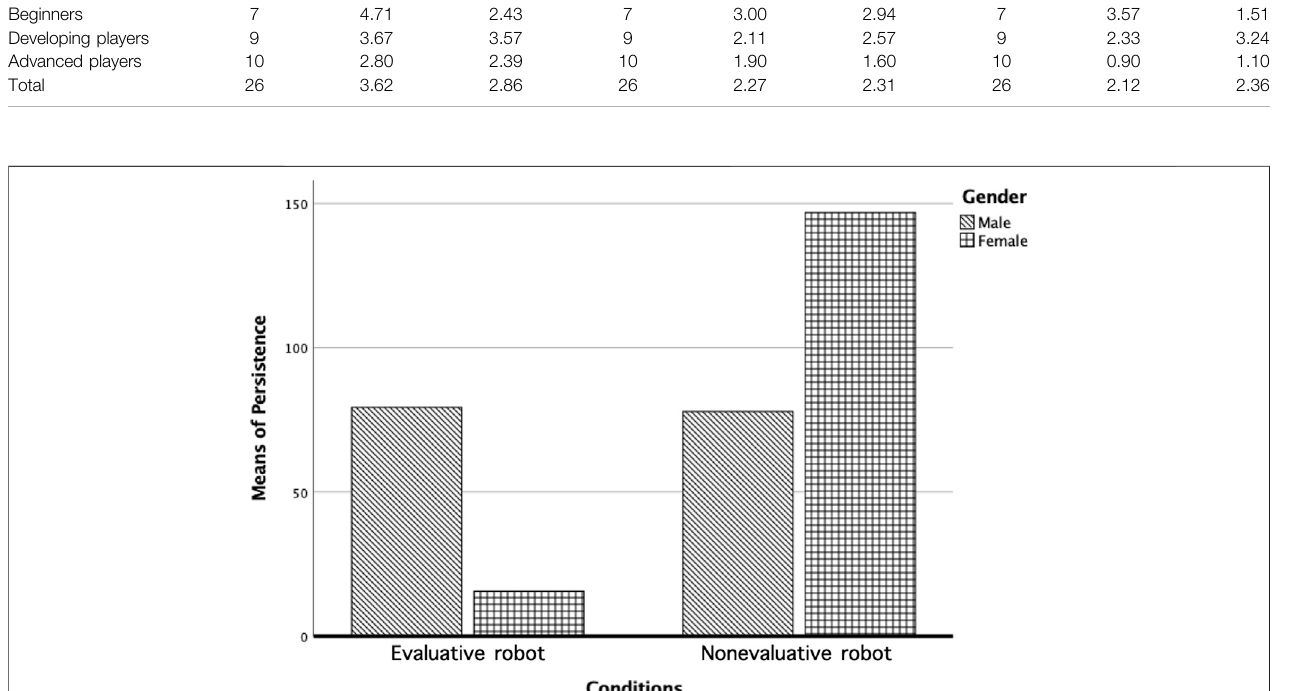
FIGURE 3 | Means of persistence of children in different gender groups in the evaluative robot condition and the nonevaluative robot condition.